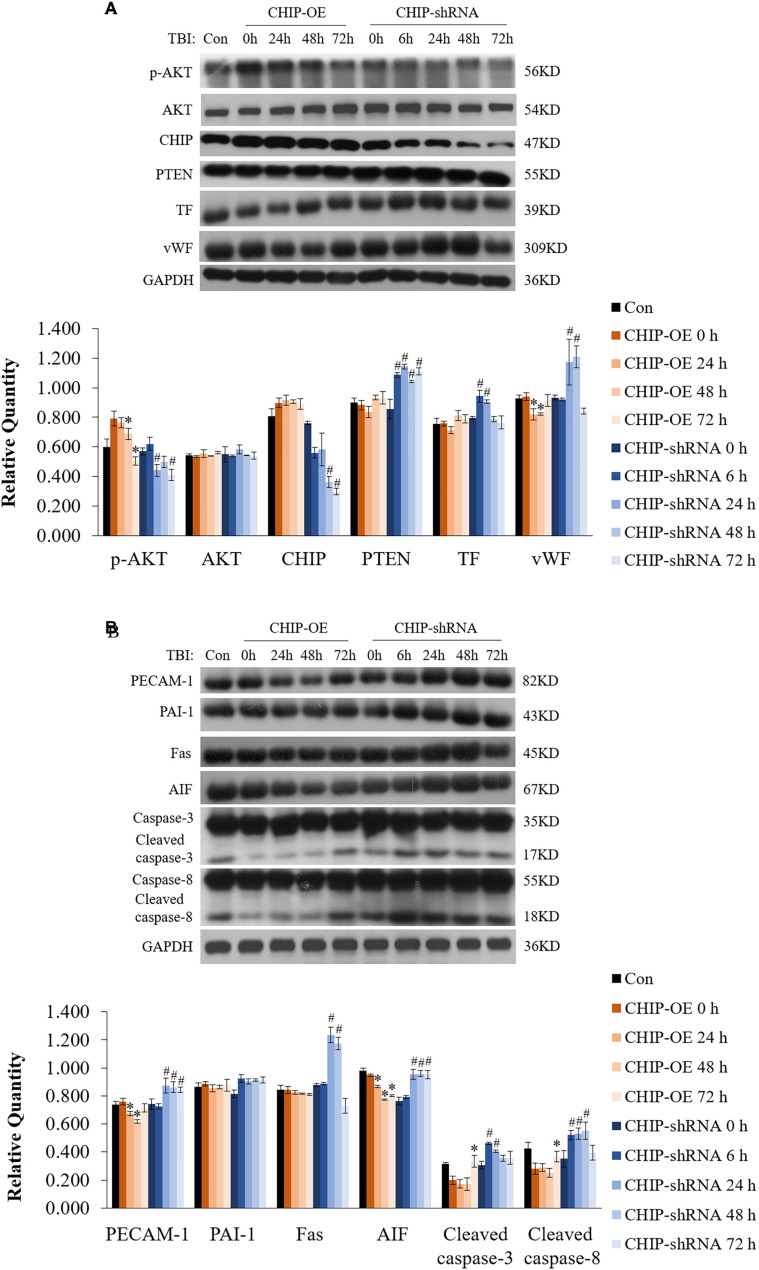
C terminus of Hsc70-interacting protein (CHIP) overexpression suppressed procoagulant and apoptosis molecule expressions in pericontusional areas after in vivo traumatic brain injury (TBI). All groups were experienced with in vivo TBI treatment. CHIP-OE group of mice were killed after 0, 24, 48, and 72 h of CCI, and CHIP-shRNA group of mice were killed after 0, 6, 24, 48, and 72 h of CCI. Three-millimeter coronal tissue section from the ipsilateral cortex centering on the impact site was obtained immediately after killing. (A) Changes of CHIP, PTEN, and p-AKT levels in each group after in vivo TBI. (B) Changes of procoagulant molecules and apoptosis molecules in each group after in vivo TBI. Quantification of proteins was normalized to glyceraldehyde-3-phosphate dehydrogenase. ∗p < 0.05 vs. the CHIP-OE-0h, #p < 0.05 vs. the CHIP-shRNA-0 h.